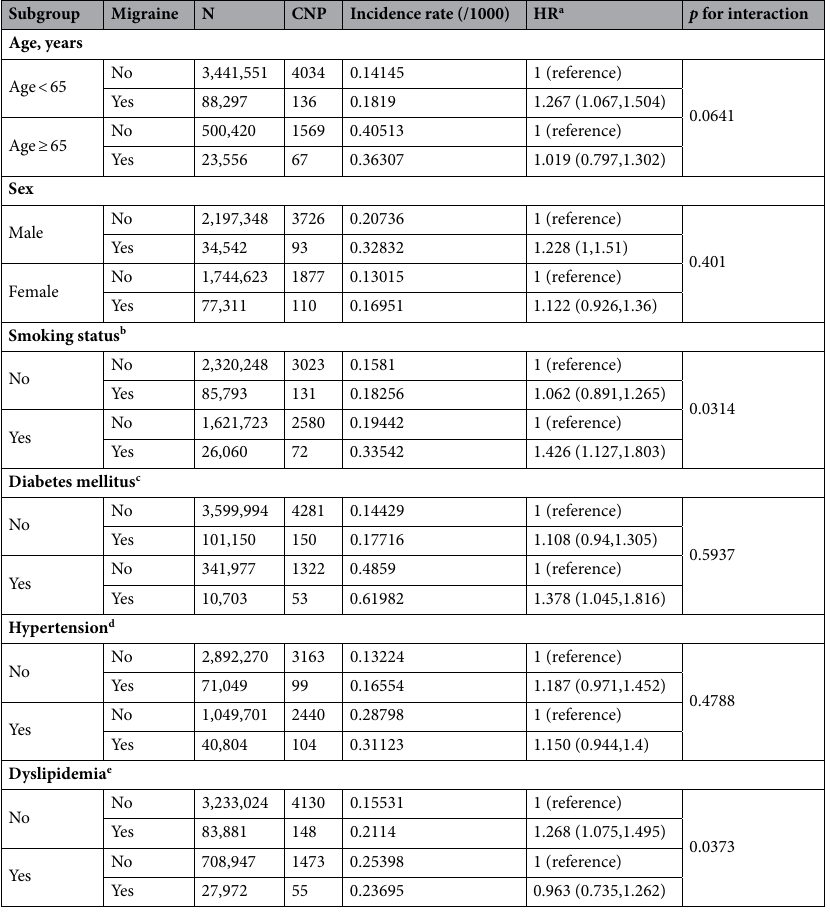
no previous data are available on gender differences in the risk of the ocular motor CNP in migraine patients. Our study showed a male gender in patients with migraines increased the risk of CNP development. Although it needs